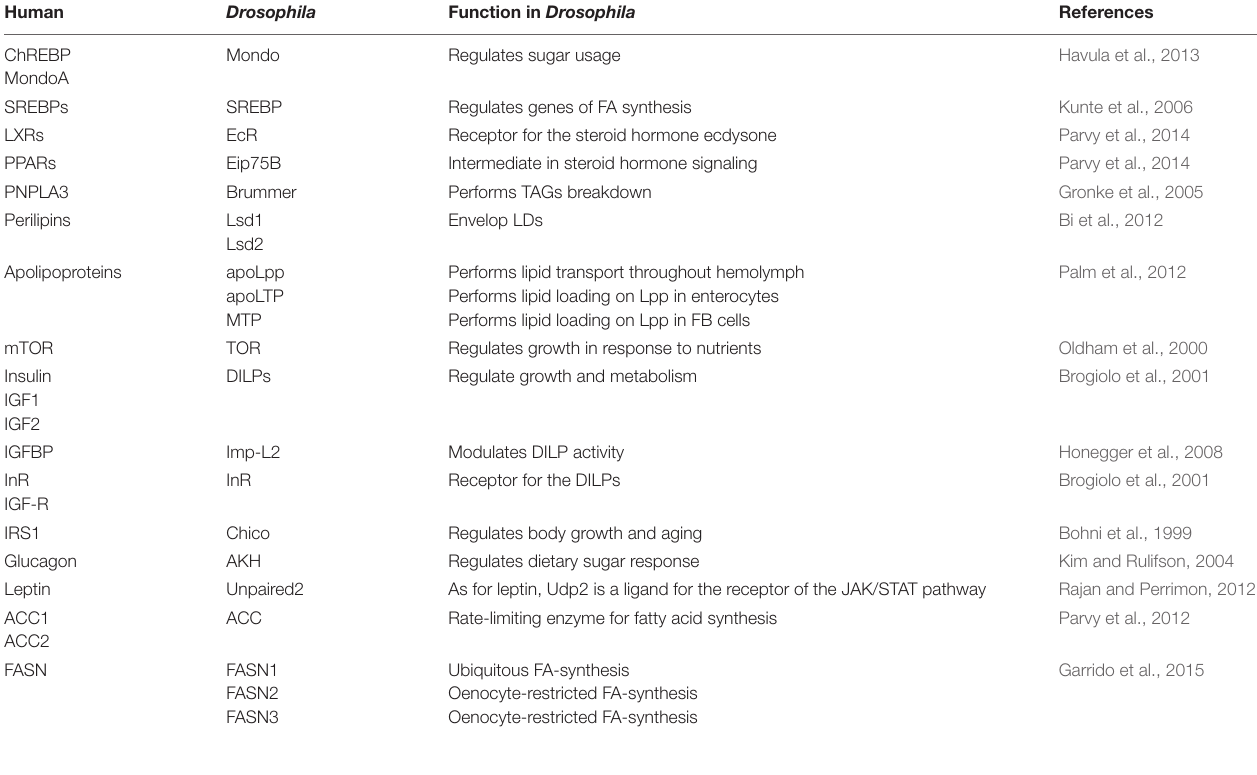
TABLE 1 | Drosophila homologs of human gene products involved in metabolic and liver disease.